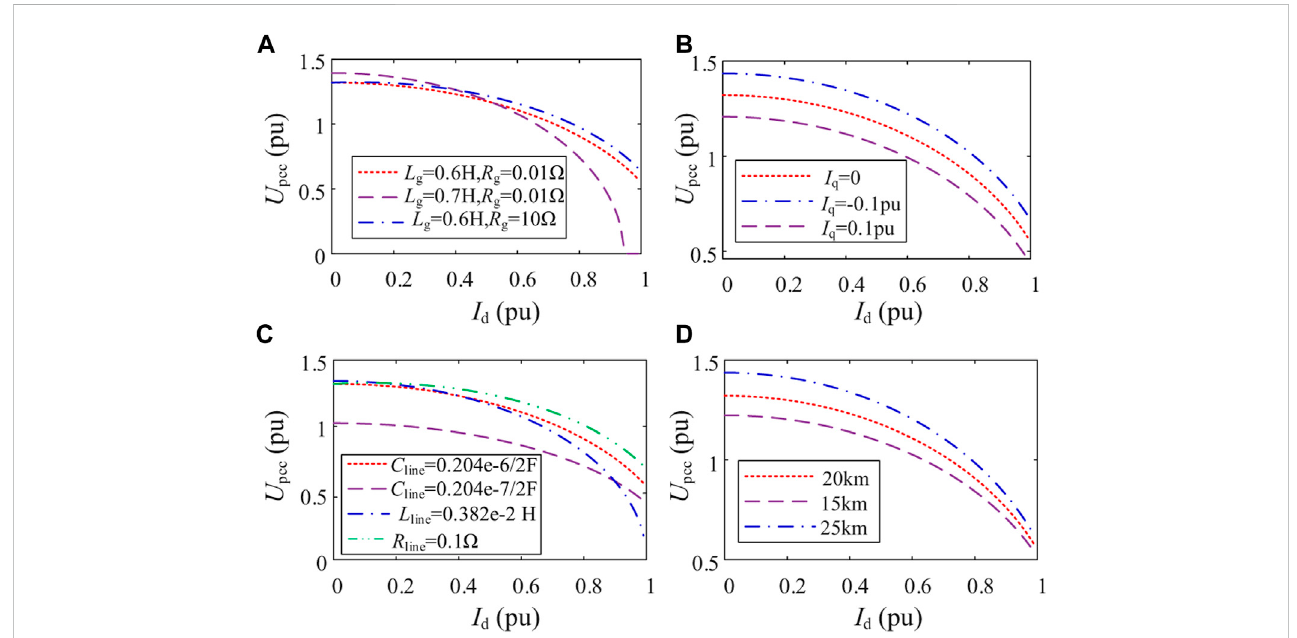
FIGURE 3 I d - U PCC curve under different parameters. (A) Grid impedance, (B) reactive current, (C) submarine cable parameters, (D) cable length.